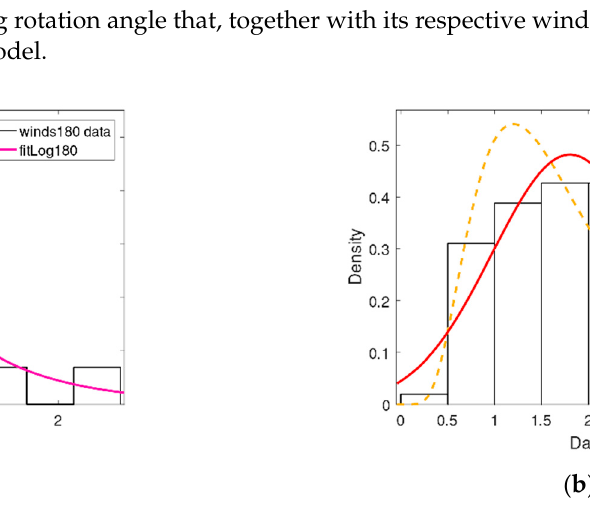
Figure 3. Fitting of the probability distribution to the wind speed data. ( a ) Logarithmic normal distribution − θ = 180°; ( b ) Normal distribution (continuous line) × logarithmic distribution (dashed line) − θ = 90°.